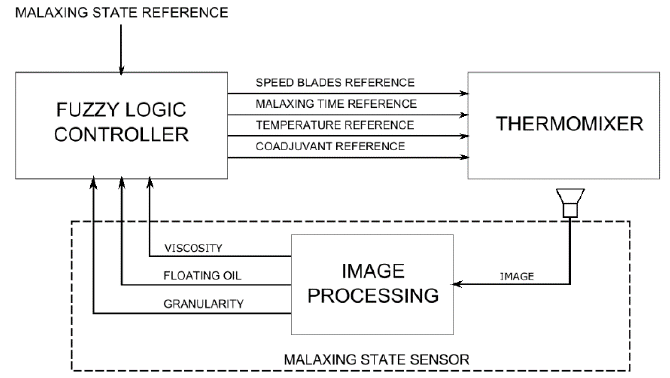
Figure 2. Flow chart of our approach.